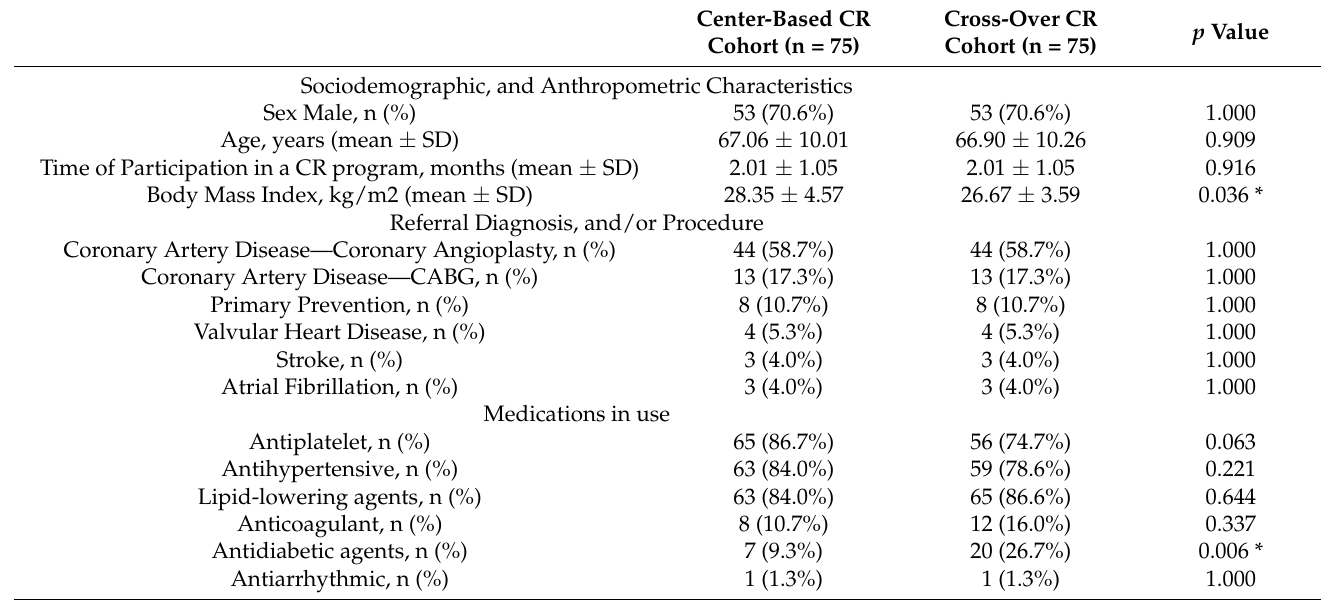
Table 1. Characteristics of individuals included in the quantitative analysis at baseline (n = 150).